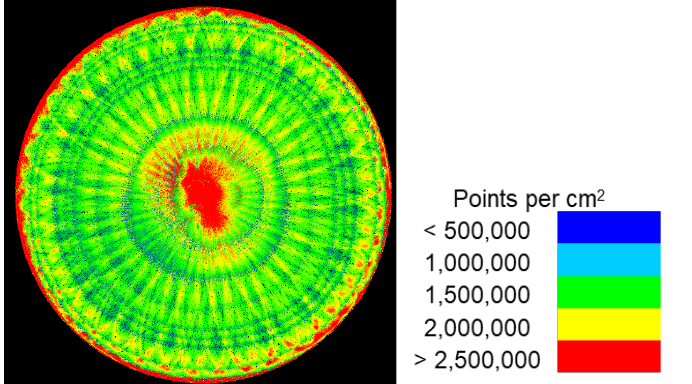
Figure 27. Livox ® Mid–40 indoor point cloud (subset of 10 observation files), colorized by surface point density (points per cm).